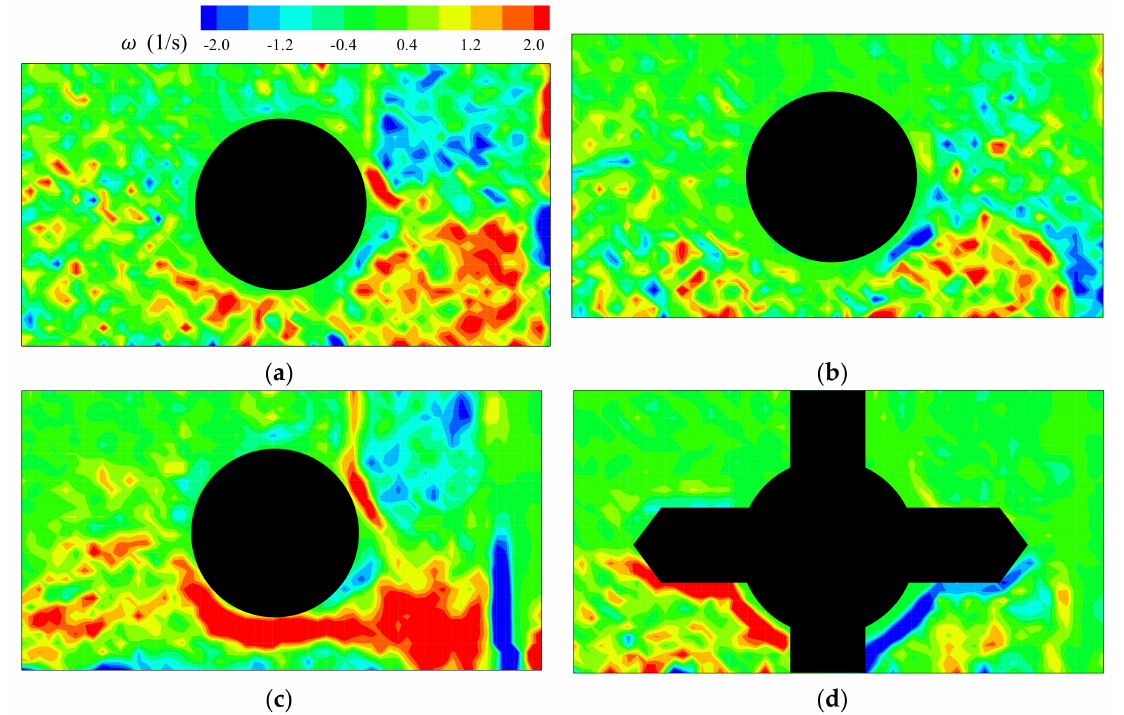
Figure 12. Vorticity distribution comparisons of the cases with and without the F-AVD: ( a ) Case Q3A0 ( z / h = 0.7); ( b ) Case Q3A1 ( z / h = 0.7); ( c ) Case Q3A0 ( z / h = 0.9); and ( d ) Case Q3A1 ( z / h =